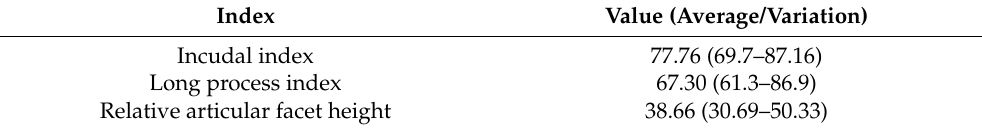
Table 8. Variance indices for the incus